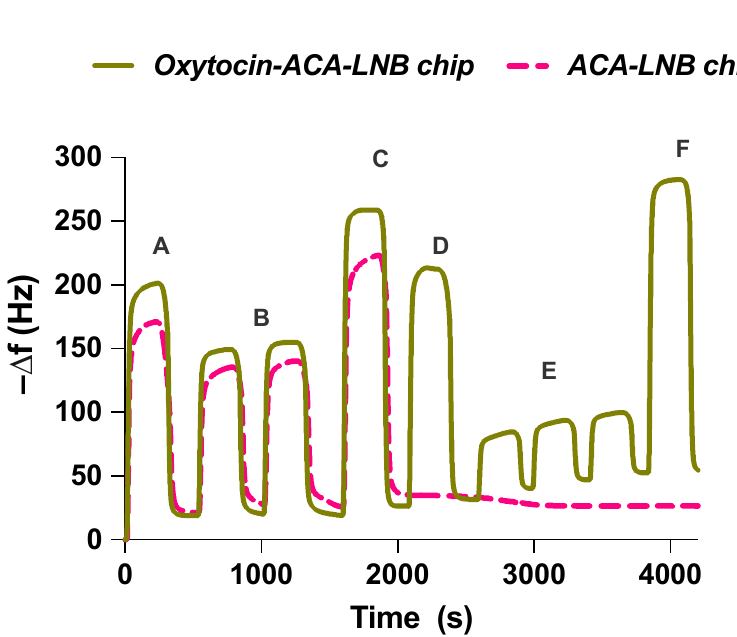
Figure 6. Schematic representation of the immobilization of oxytocin on QCM chips for the detection of O-NPs; ( A ) LNB carboxyl surface activation by EDC/sulfo-NHS, ( B ) ACA immobilization, ( C )